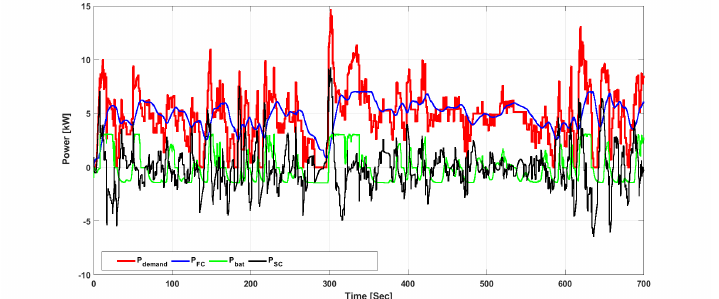
Figure 12. Power demand ( P demand ), FC power ( P FC ), battery power ( P bat ), and supercapacitor power ( P SC ) for the EMS based on FDFLC.